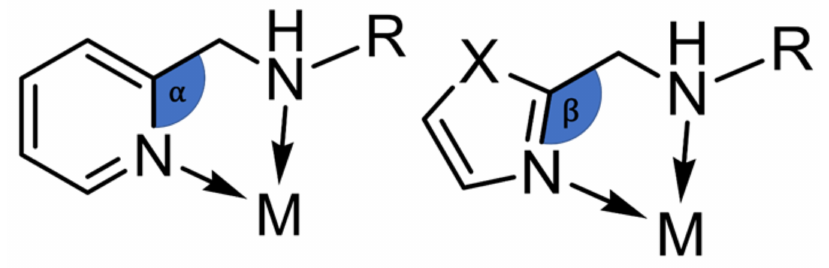
Figure 6. Scheme of different coordination angles between a 6-membered ring ( left ) and 5-membered ring ( right ) in the ligand side arm.